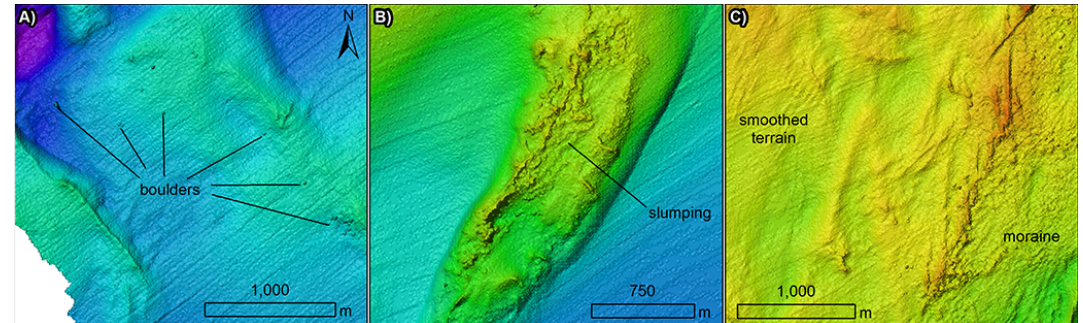
Figure 4. Magnified views of the Tremadog Bay seabed. Locations of each box are given in Fig. 2a. (A) Moraines and boulders on the western edge, (B) slumped moraines, and (C) contrasts between the smoothed terrain and moraine deposits to the north. Contains Maritime and Coastguard Agency bathymetry data © Crown